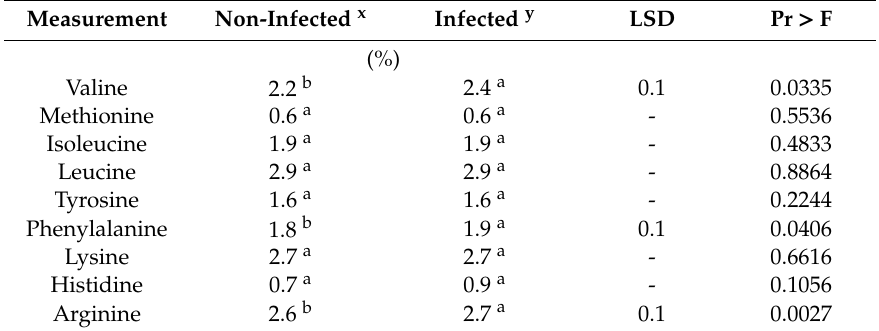
Table 4. The comparison of non-infected (non-symptomatic) compared to infected soybean seed as it influenced seed amino acids content. The field experiment was conducted in 2019 at the Delta Research and Extension Center in Stoneville, MS.